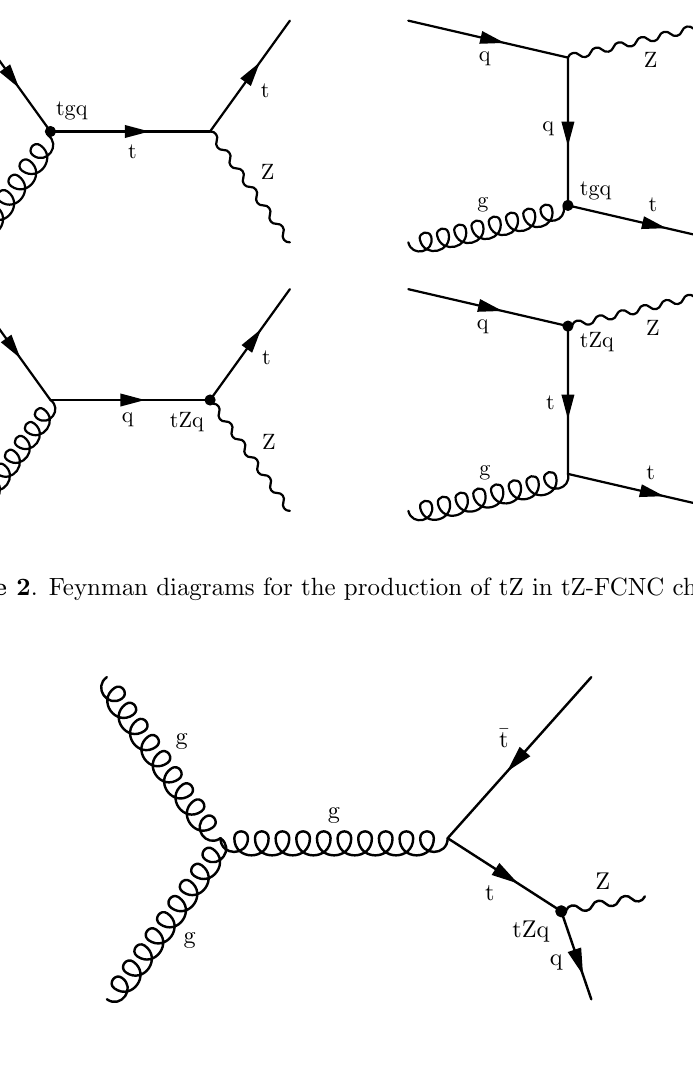
Figure 3 . Feynman diagram for the production of tZq in the tt-FCNC